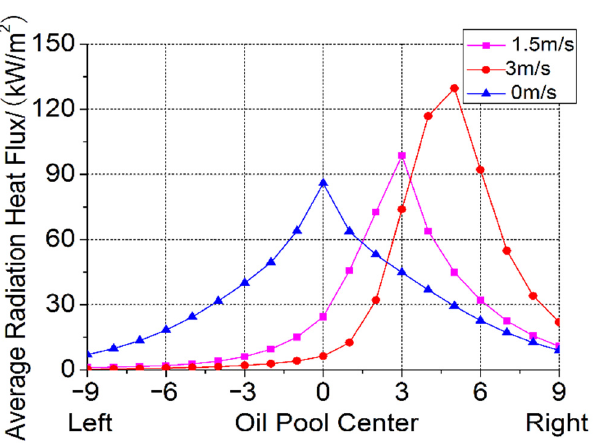
Figure 13. The average radiation heat flux of different detecting points under different wind speeds.